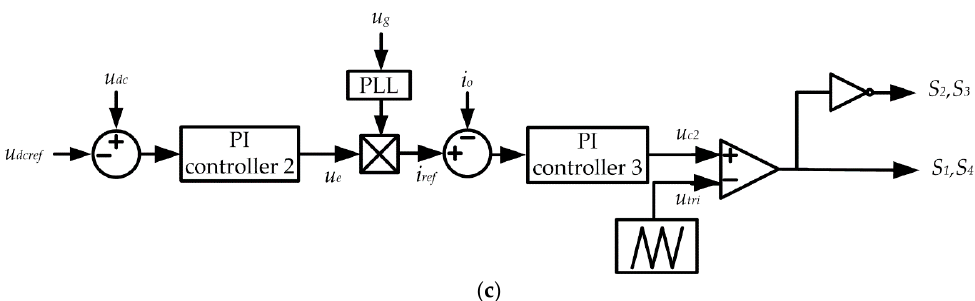
Figure 1. Diagram of a single-phase two-stage grid-connected photovoltaic system: ( a ) Power stage circuit; ( b ) MPPT controller; ( c ) double loop controller.